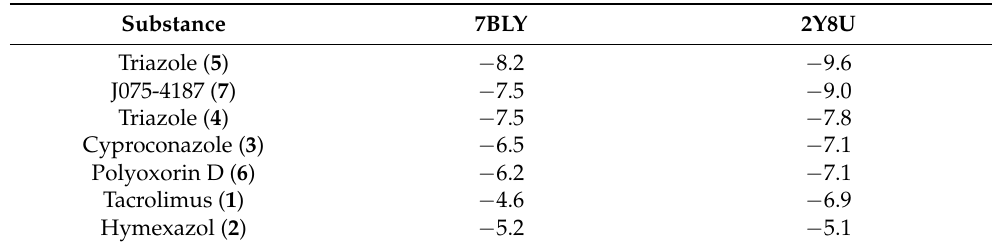
Table 1. Affinity to binding sites of Aspergillus niger CDA (PDB ID: 7BLY) and A. nidulans CDA (PDB ID: 2Y8U), kcal/mol.